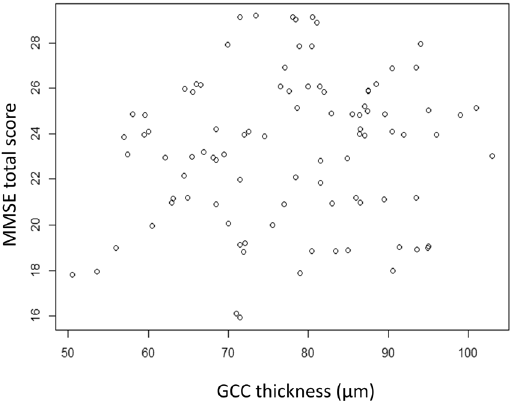
Figure 6. The relationship between the mean deviation and the ganglion cell complex thickness. No significant relationship was observed (p = 0.23, linear mixed model).